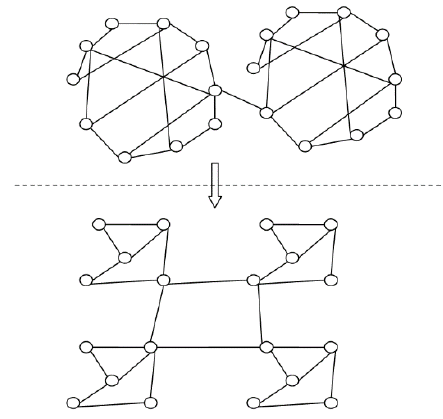
Figure 7. Deviation of the ACC and the APL.